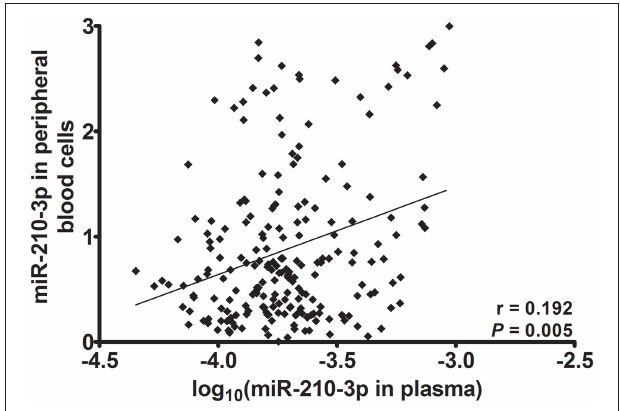
FIGURE 1 | Spearman’s rank correlation between miR-210-3p in plasma and in peripheral blood